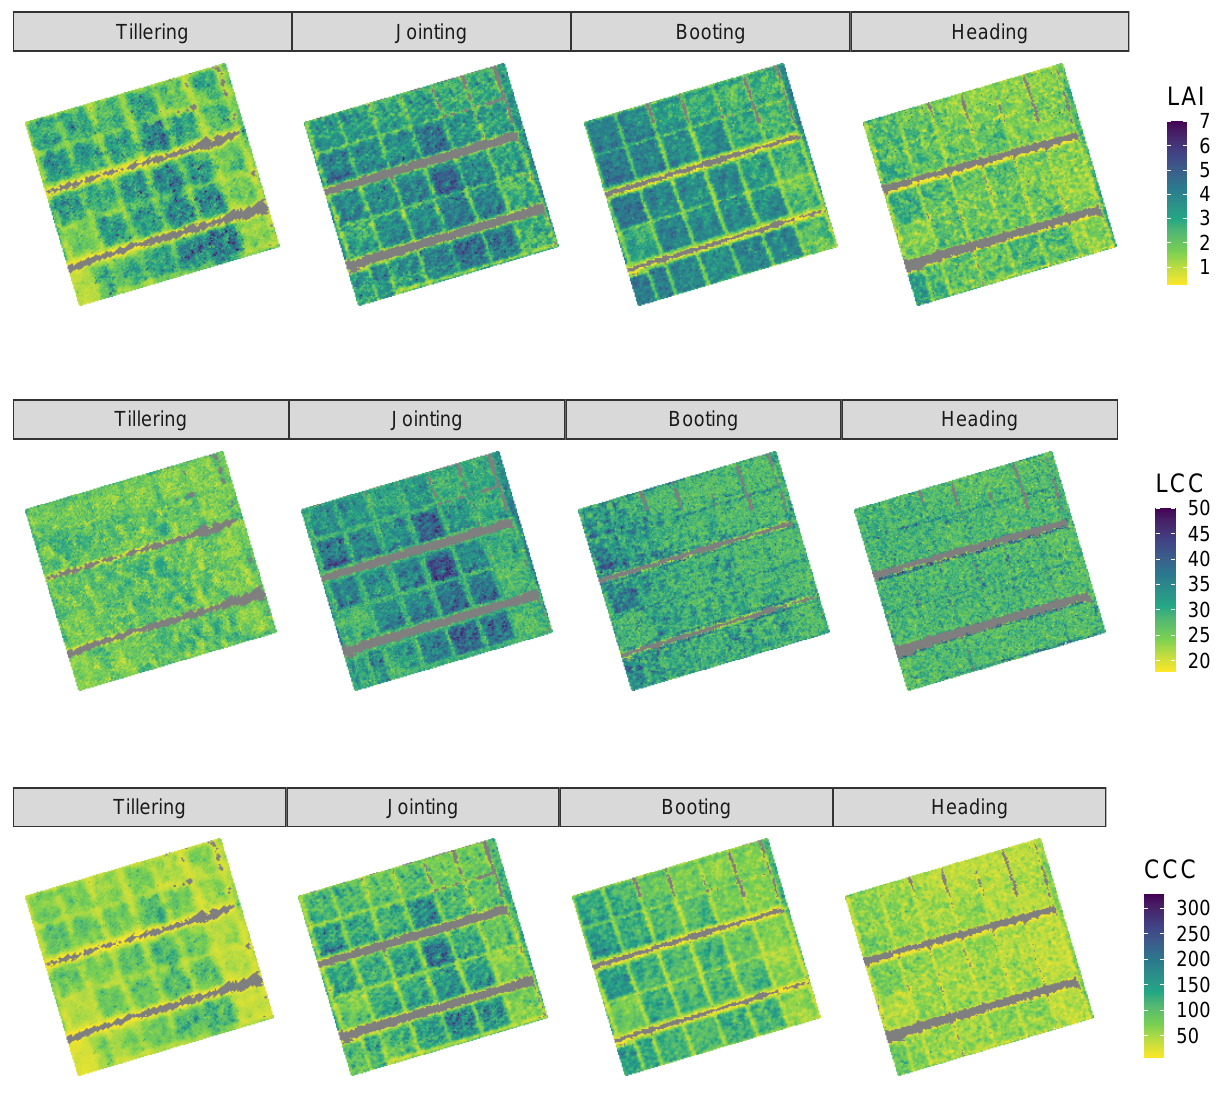
Figure 4. Pixel-wise inversion results with flooded soil signature for leaf area index (LAI, m 2 m − 2 ), leaf chlorophyll content (LCC, µ g cm − 2 ), and canopy chlorophyll content (CCC, µ g cm − 2 ) for each tillering, jointing, booting, and heading growth